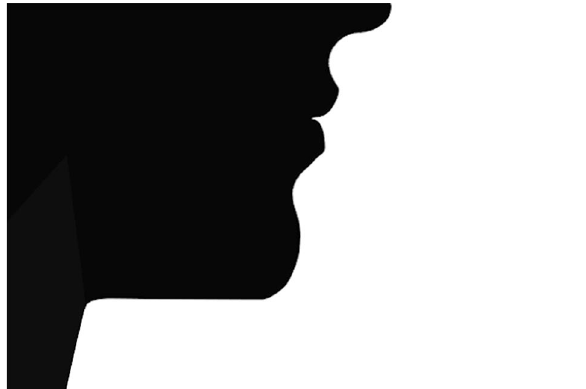
Figure 3. Silhouette of the “ideal” profile redrawn from the publication of Czarnecki et al., 1993.